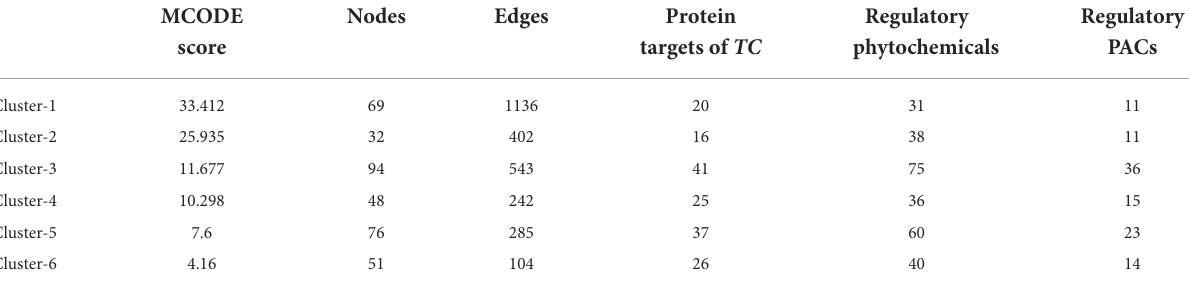
MCODE Nodes Edges score